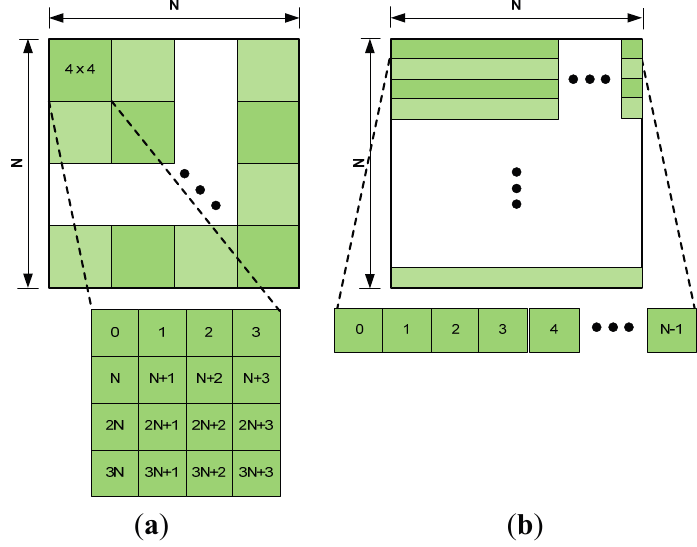
Figure 1. Pixel access sequence in image sensor using two topologies: ( a ) 4 × 4 block; ( b )